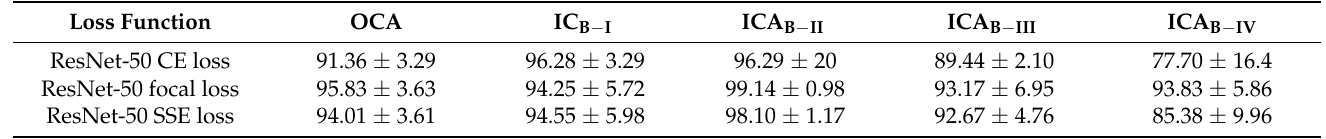
Table 7. Confusion matrix of 5-folds of the best test (* OCA) and (** ICA).